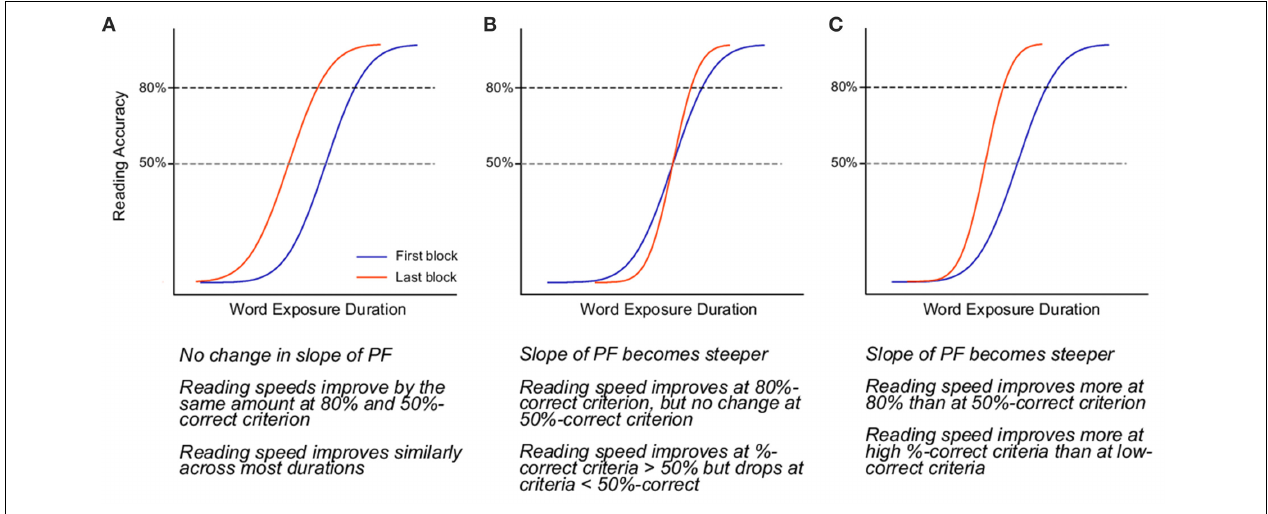
FIGURE 1 | Panels A–C illustrate the three possible outcomes of perceptual